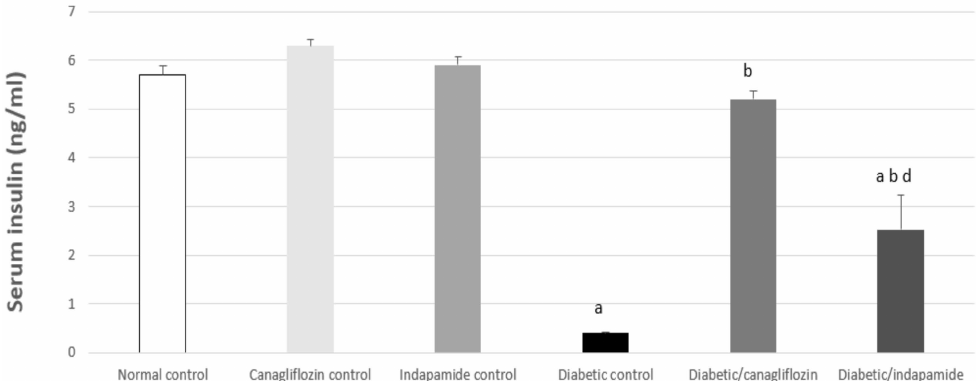
Figure 4. Impact of daily oral CANA and INDA treatment on serum insulin: oral CANA and INDA treatments were initiated once daily for 4 weeks. Data represent the mean ± S.E.M. (6 rats/group). ANOVA followed by post hoc Tukey–Kramer test at ( p < 0.05) was used for statistical comparison; a against normal CTRL, b against diabetic CTRL, d against diabetic/CANA.